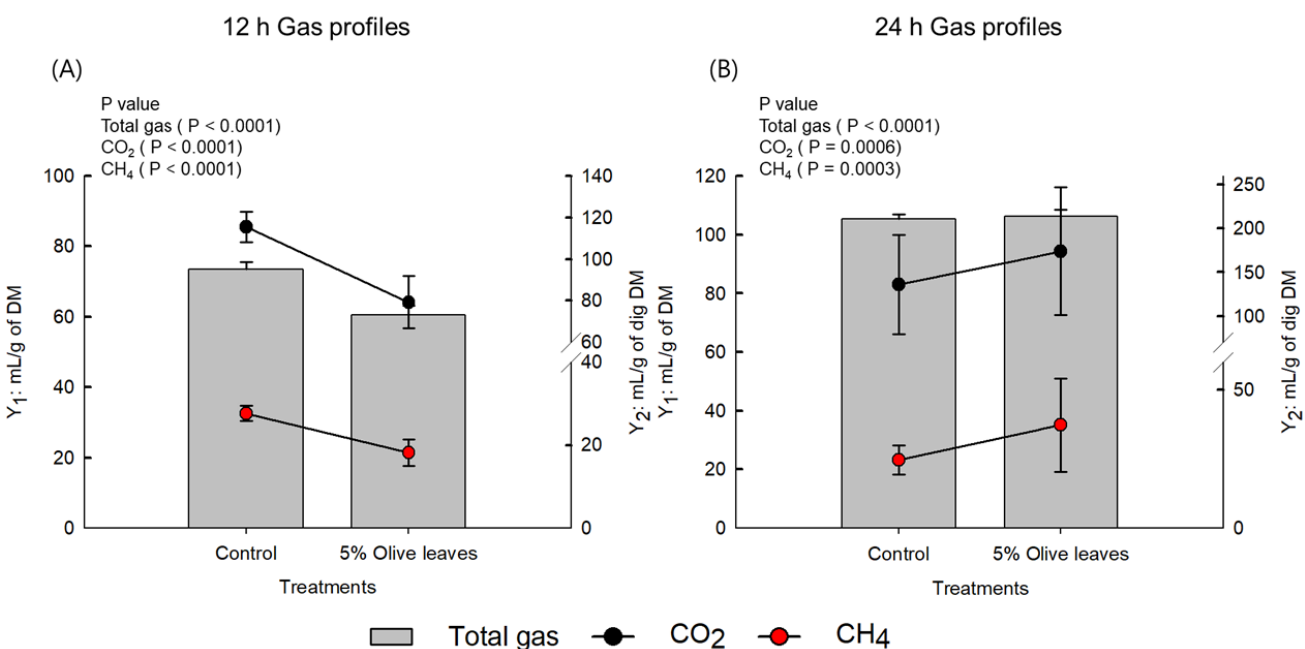
Figure 1. Effects of 5% olive leaves (OLs) on gas profile at ( A ) 12 and ( B ) 24 h. Y 1 axis represents gas production unit (mL/g of DM) and Y 2 axis represents gas production unit (mL/g of dig DM). Error bars indicate standard error of the mean ( n = 3). Table 6. Antimicrobial activities of 5% olive leaves (OLs)